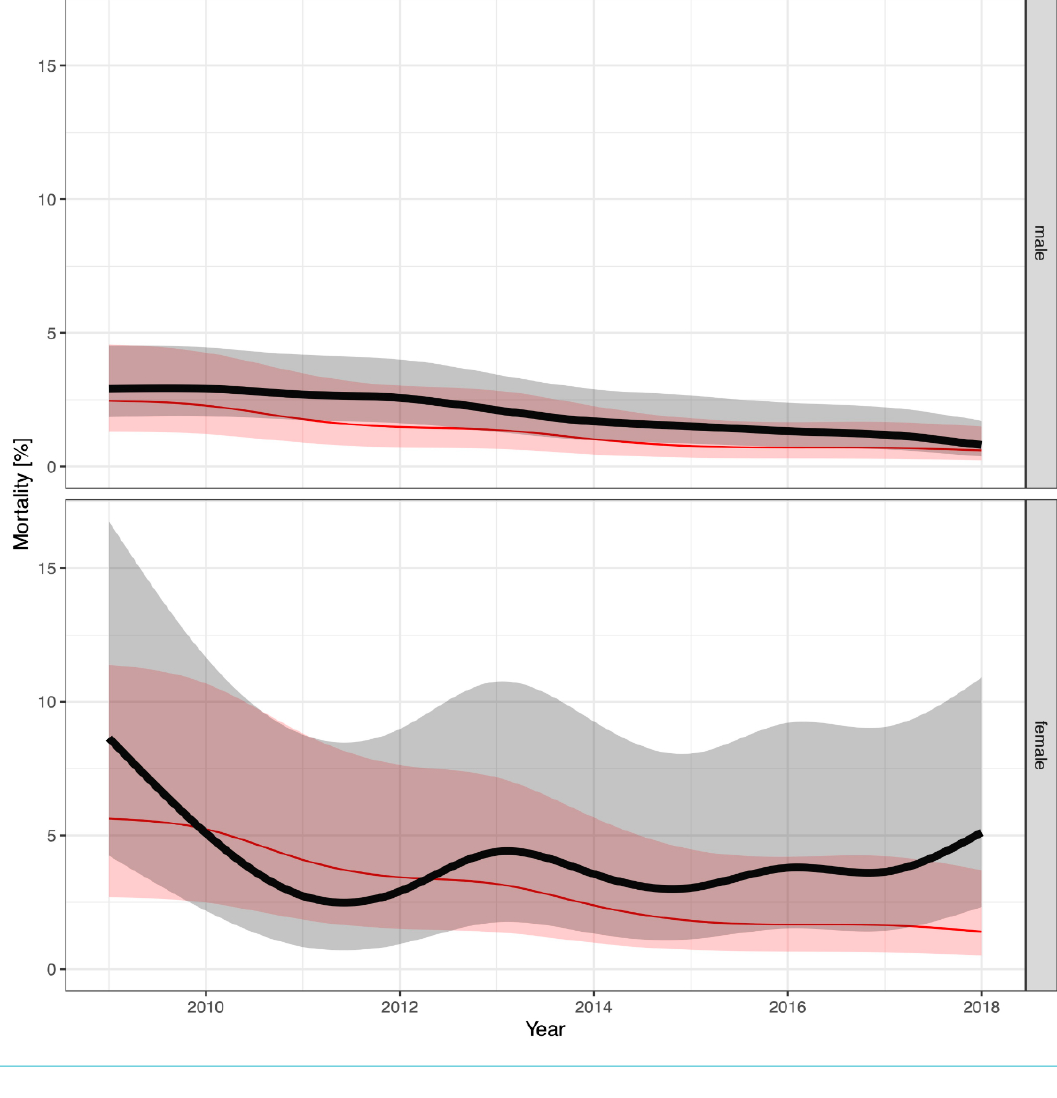
Table 2: Treatment